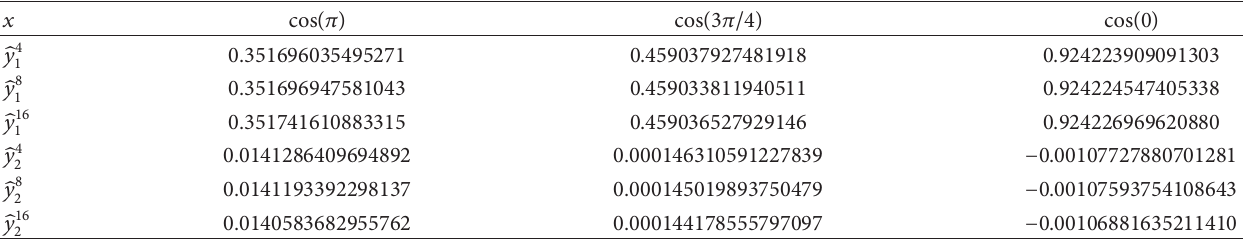
1 (𝑒 𝑖𝜔(𝑥−𝑡) /|𝑥 − 𝑡| 0.5 )𝑦(𝑡)𝑑𝑡 = 𝑒 𝑥 with 𝜔 = 10 3 . −1